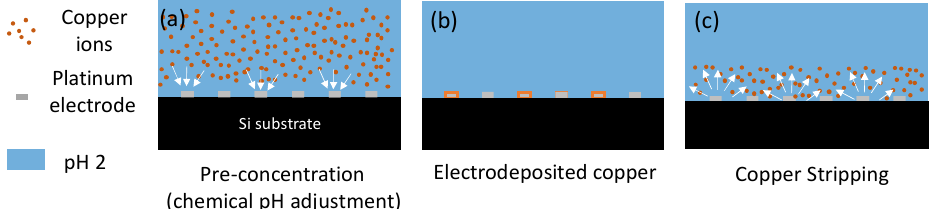
Figure 2. Schematic of electrochemical detection of copper. ( a ) pre-concentration at the surface of the working electrode; ( b ) electrodeposition of copper at the surface of the electrode and ( c ) stripping of deposited copper back in solution.